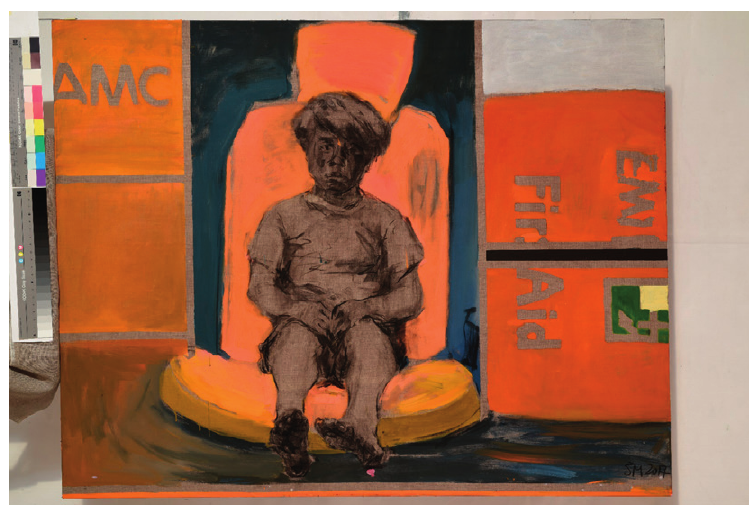
Figure 1. Sigita Maslauskaitė-Mažylienė. A Boy (2017)